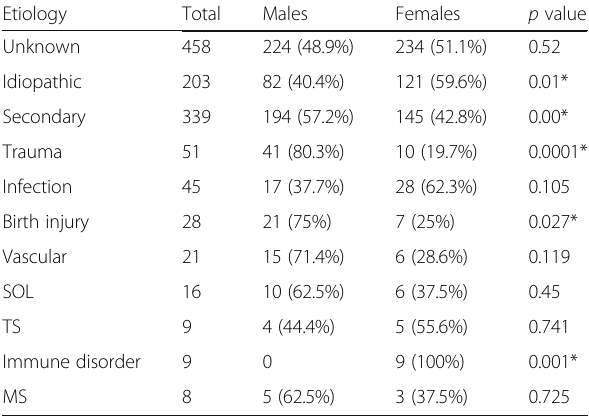
Table 6 Gender differences in AED